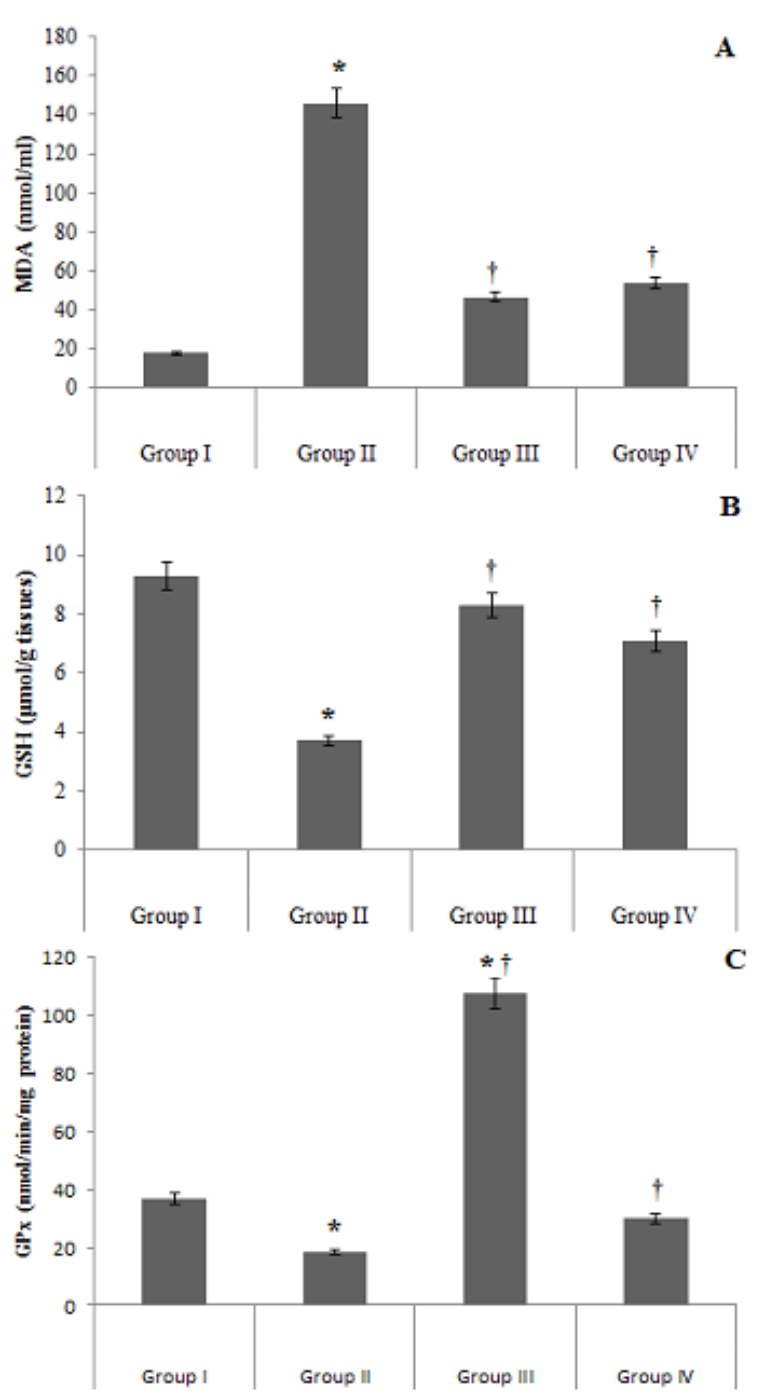
FIGURE 2 - Effects sitagliptin on APAP-induced alterations in oxidative stress markers in hepatic tissues. 2A: malondialdehyde (MDA) level; 2B: reduced glutathione (GSH) level; 2C: glutathione peroxidase (GPX) activity. Group I: normal control group; group II: APAP-treated group; group III: sitagliptin-treated group (10 mg/kg/day) 5 days before APAP administration; group IV: N -acetylcysteine-treated group (100 mg/kg orally). Data are expressed as mean ± SEM for n = 10. * : P < 0.05 compared to normal control group; †: P < 0.05 compared to APAP control group by one-way ANOVA test followed by post hoc